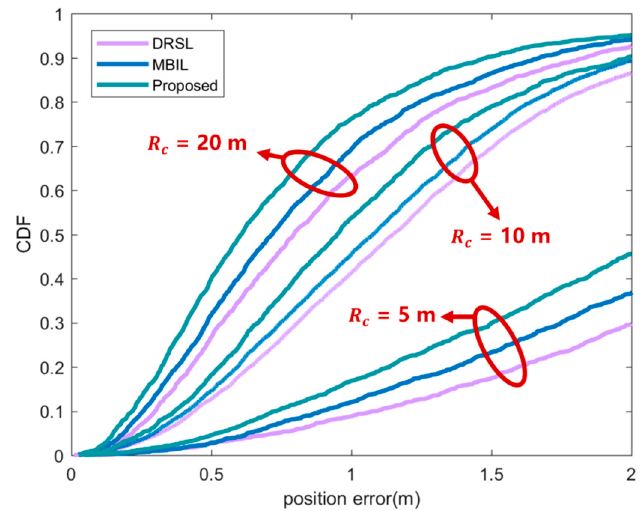
Figure 6. CDF of position error under different communication distance R c . In the figure, the purple line represents the DRSL source selection location algorithm proposed in [30], the blue line represents the MBIL algorithm in [23] and the green line represents the source optimization algorithm proposed in this